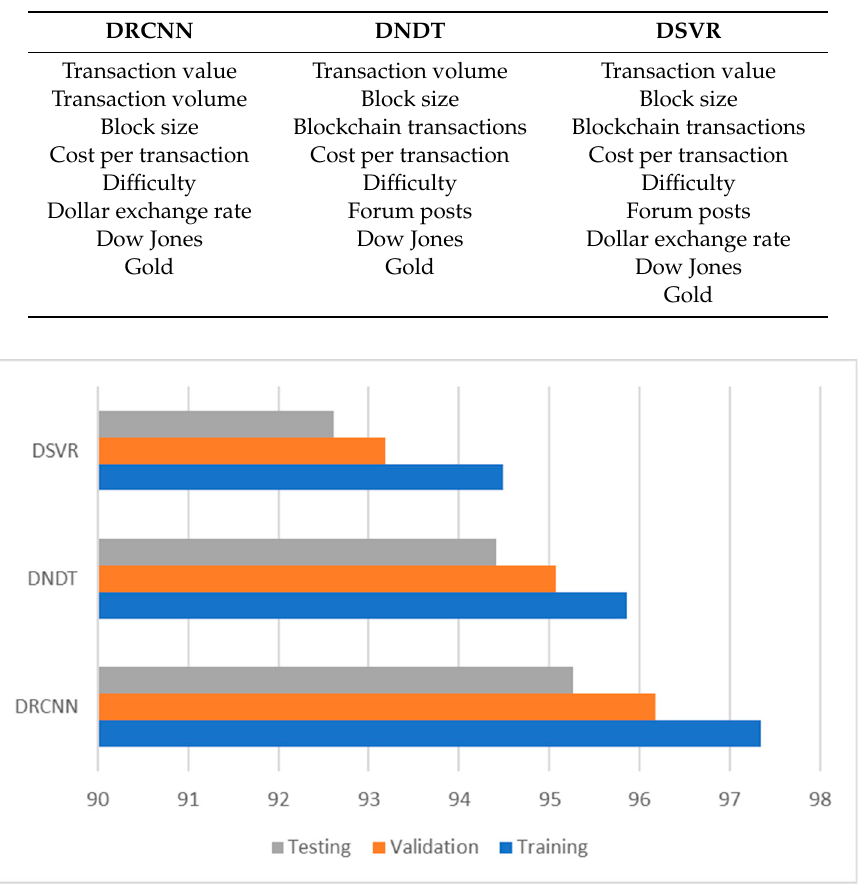
Figure 1. Results of accuracy evaluation: classification (%).